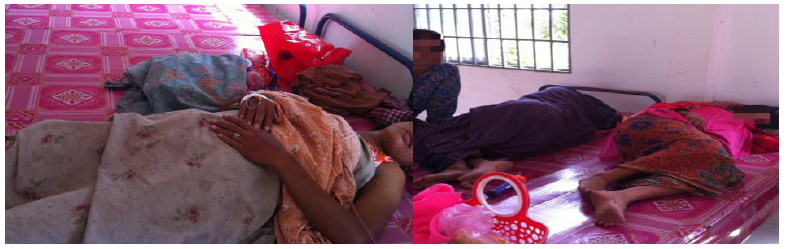
Figure 1. Health facility postnatal area.